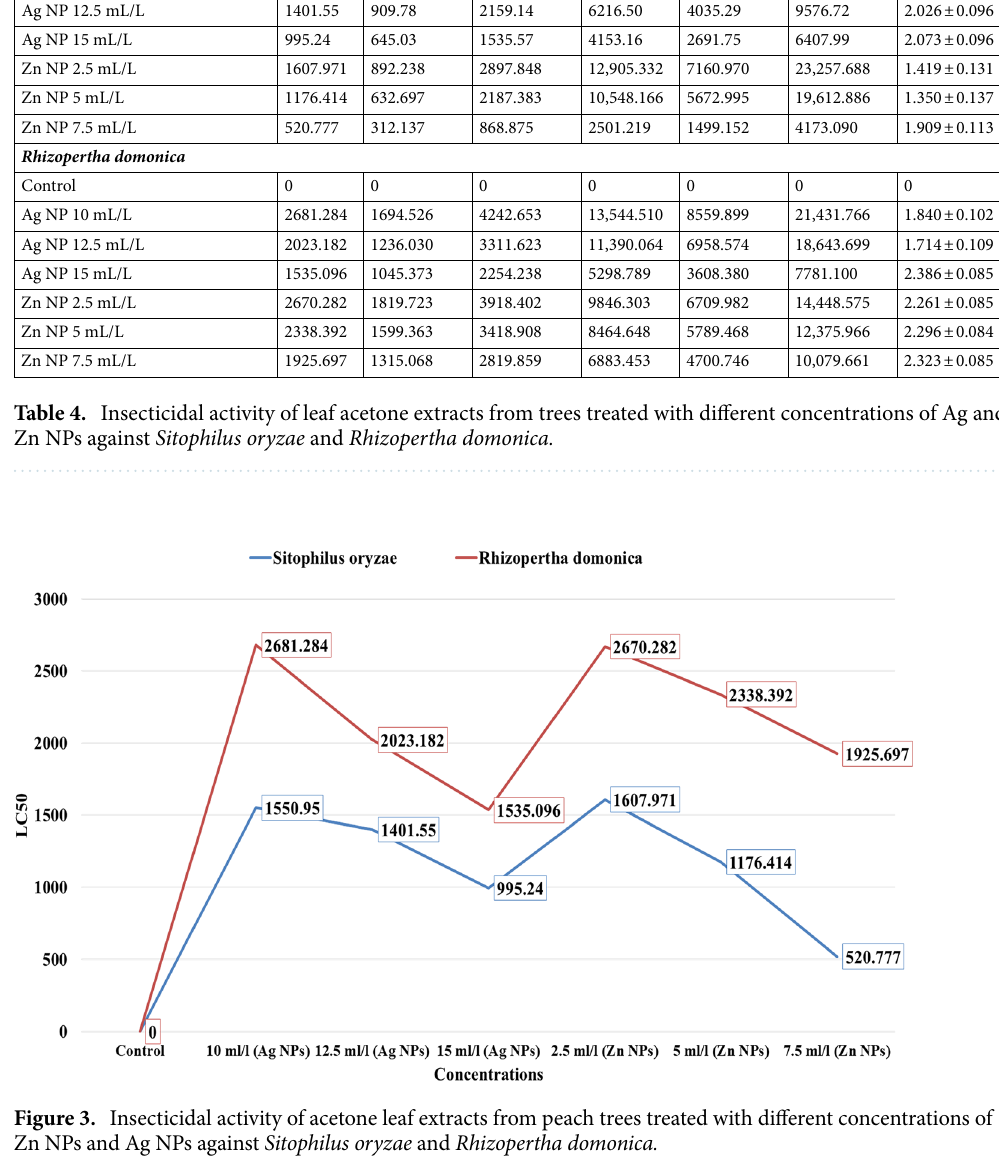
Table 7 and Fig. 4 present the changes in phenolic com- pounds of acetone leaf extracts from peach trees as affected by different treatment concentrations of nanopar- ticles. Catechol found in 4.22 mg/g in extract from leaves sprayed with Ag NPs 10 mL/L and control (without foliar application) and decreased to 1.22 mg/g in leaves treated with Ag NPs 12.5 mL/L, and then it was not detected in other treatments. Caffeic acid was found in 6.15 mg/g in both leaves from control and treated with Ag NPs 10 mL/L and not detected in other treatments. The high amount of ferulic acid detected in extract from leaves treated with Ag NPs 10 mL/L and control (17.09 mg/g) and in Zn NPs at 2.5 and 5 mL/L (12.09 mg/g). High amounts of p-Coumaric acid (6.06 mg/g) in extract from leaves treated with Ag NP 12.5 mL/L, gallic acid (11.14 mg/g) from leaves treated with Zn NPs at 2.5 and 5 mL/L, chlorogenic acid (8.14 mg/g) when leaves treated with Ag NPs 12.5 mL/L, p-hydroxybenzoic acid with 10.66 mg/g (leaves treated with Ag NP 15 mL/L) and 8.55 mg/g (leaves treated with Zn NPs at 2.5 and 5 mL/L), cinnamic acid at 14.17 mg/g as leaves sprayed with Ag NP 12.5 mL/L, salicylic acid at 6.13 and 7.51 mg/g when application of Ag NPs at 10 and 15 mL/L, was used, epicatechin at 7.11 and 9.03 mg/g as leaves in control